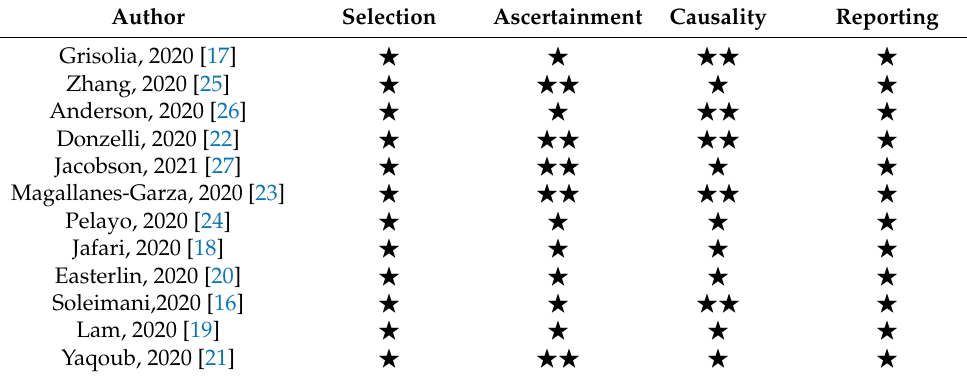
Table 2. Quality assessment of the included